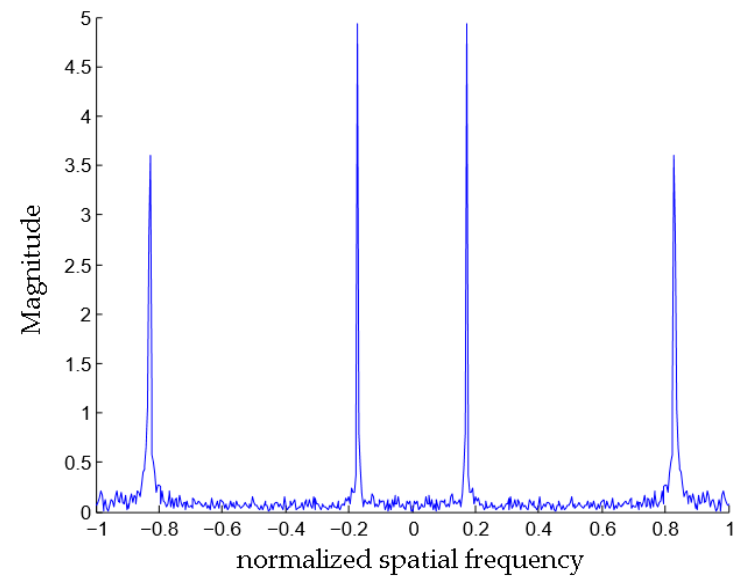
Figure 4. Spatial spectrum obtained from FFT analysis.